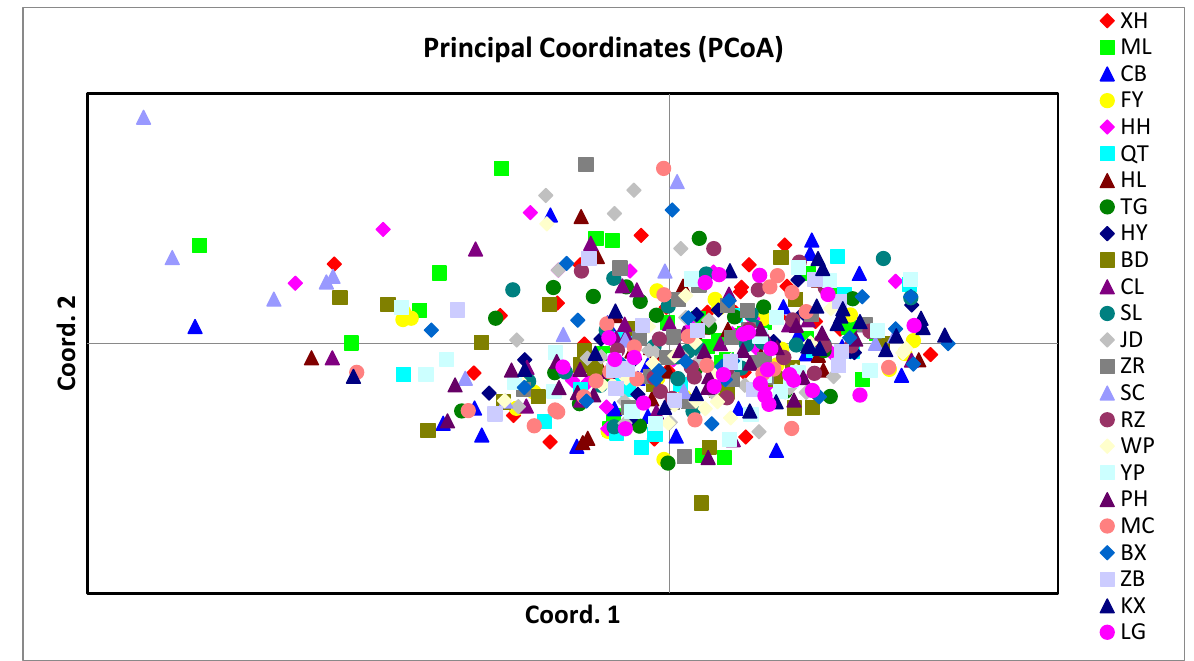
Figure 2. ( a ). Estimates of optimal K (number of clusters) from Δ K . ( b ). The structure bar shows the results of the Bayesian analysis of 24 populations of S. litura . Each individual is shown by a verti- cal bar. Blue, green and red represent the three clades.